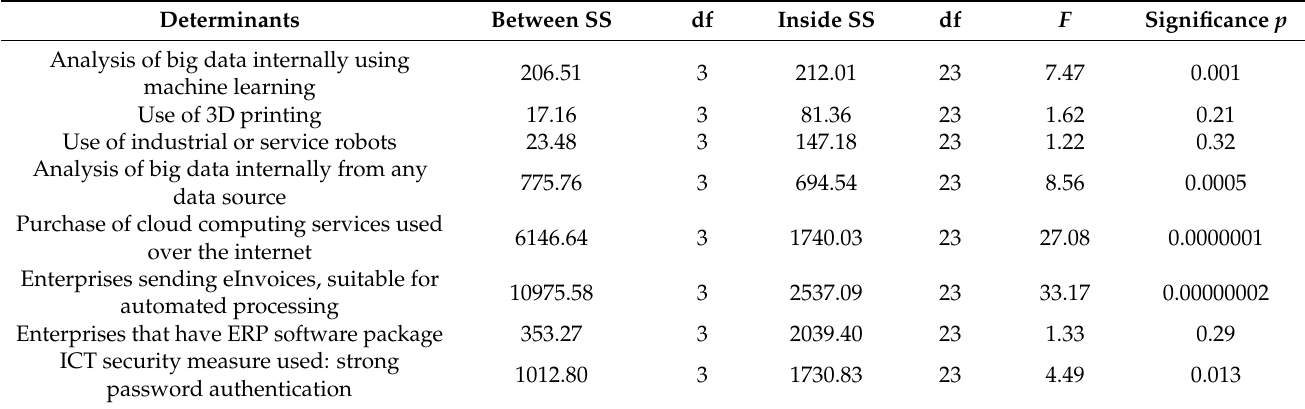
Table 10. Analysis of variance for digital maturity